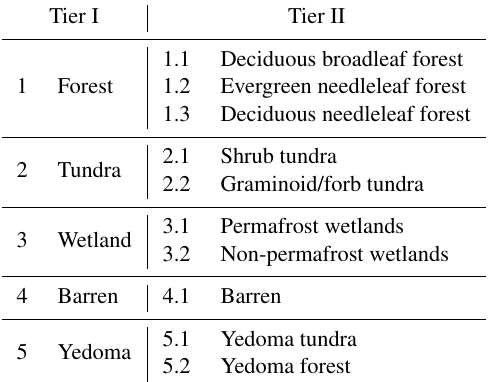
Table 2. Hierarchical structure of the two-tier land cover class sys- tem applied to the pedons based on field